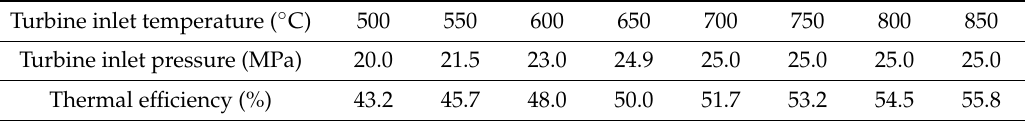
Table 1. Turbine inlet pressures at different turbine inlet temperatures for maximum thermal efficiency of the recompression Brayton cycle with partial cooling